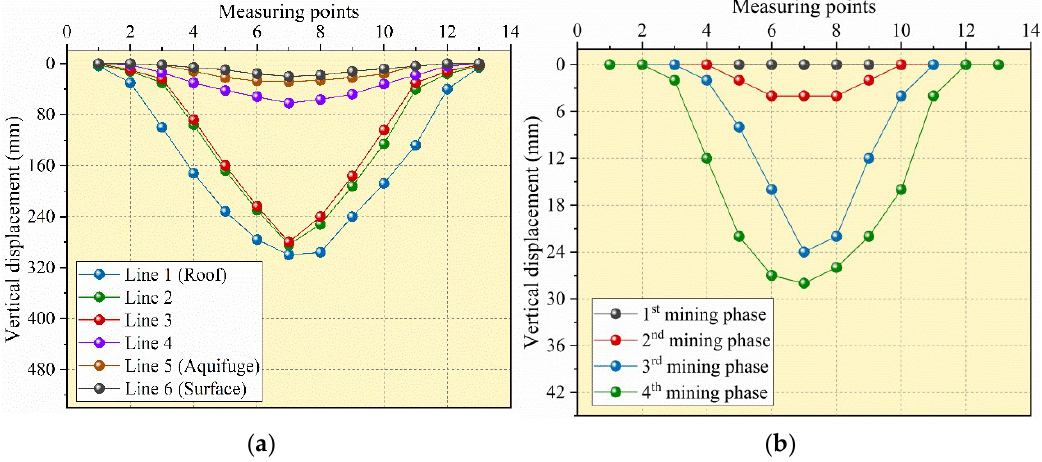
Figure 9. The deformation of the overburden and the aquifuge. ( a ) The vertical displacement of 6 survey lines after all MRs are extracted and backfilled; ( b ) the vertical deformation of the aquifuge during 4 mining phases.